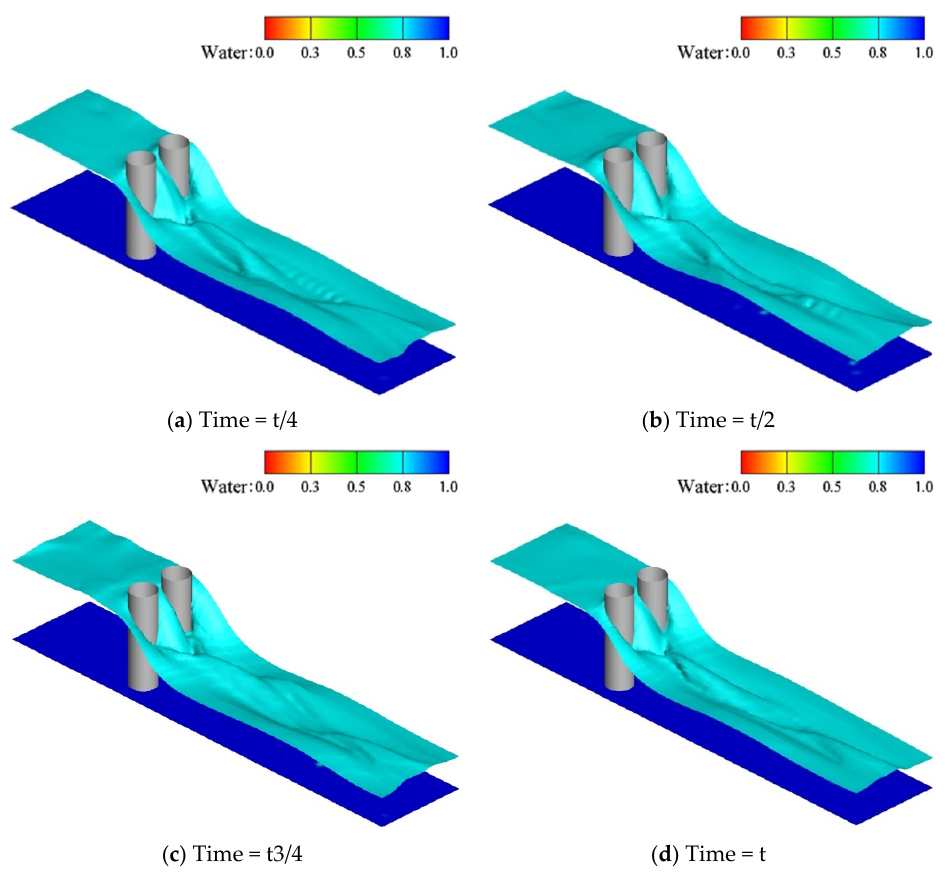
Figure 7. Evolution of free surface within one period at T / D = 1.5, G / D = 1.0. ( a ) and ( b ) are the shape of free face in 1/4 period and 1/2 period, ( c ) and ( d ) are in 3/4 period and the last moment. It can be seen from Figure 7 that the width of the flow area was reduced due to the cylinders, resulting in the difference between the surface elevation in the downstream and the upstream. The difference Δ H may, as an approximation, be defined as Equation (10).